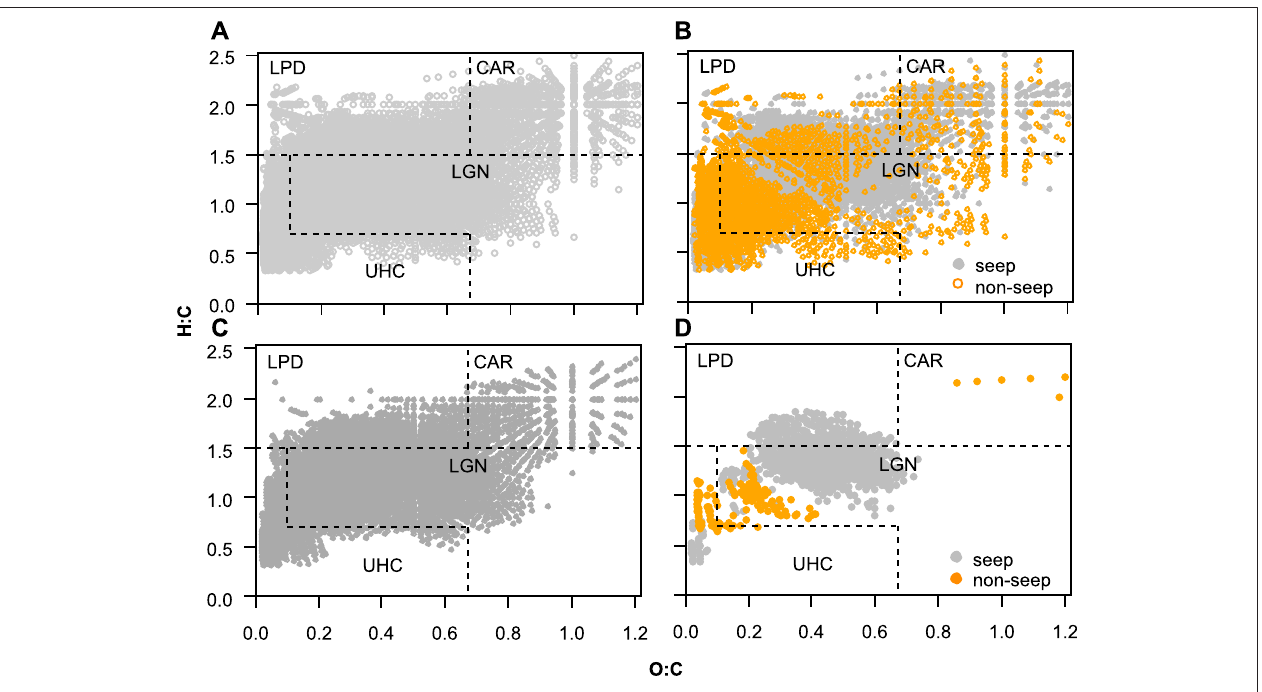
FIGURE 6 | (A) All assigned dissolved organic matter formulas in all samples (B) unique molecular formulas that are found in seep (grey) and non-seep (orange) samples (C) molecular formulas commonly found in seep and non-seep samples (D) Seep versus non-seep associated formulas based on comparisons by IndVal analysis (IndVal ≥ 0.7; p ≤ 0.01). Each point in the diagrams represents a single formula assigned from one resolved mass spectral peak. Note: these van Krevelen diagramscontainmolecularformulasfromcombinedpositiveandnegativemodeESIFT-ICRMSassignments.AbbreviationsareLPD,lipid-andprotein-like;CAR, carbohydrate-like; LGN, lignin- &tannin-like; UHC, unsaturated hydrocarbon- &condensed aromatic-like; O:C, oxygen to carbon ratio; H:C, hydrogen to carbon